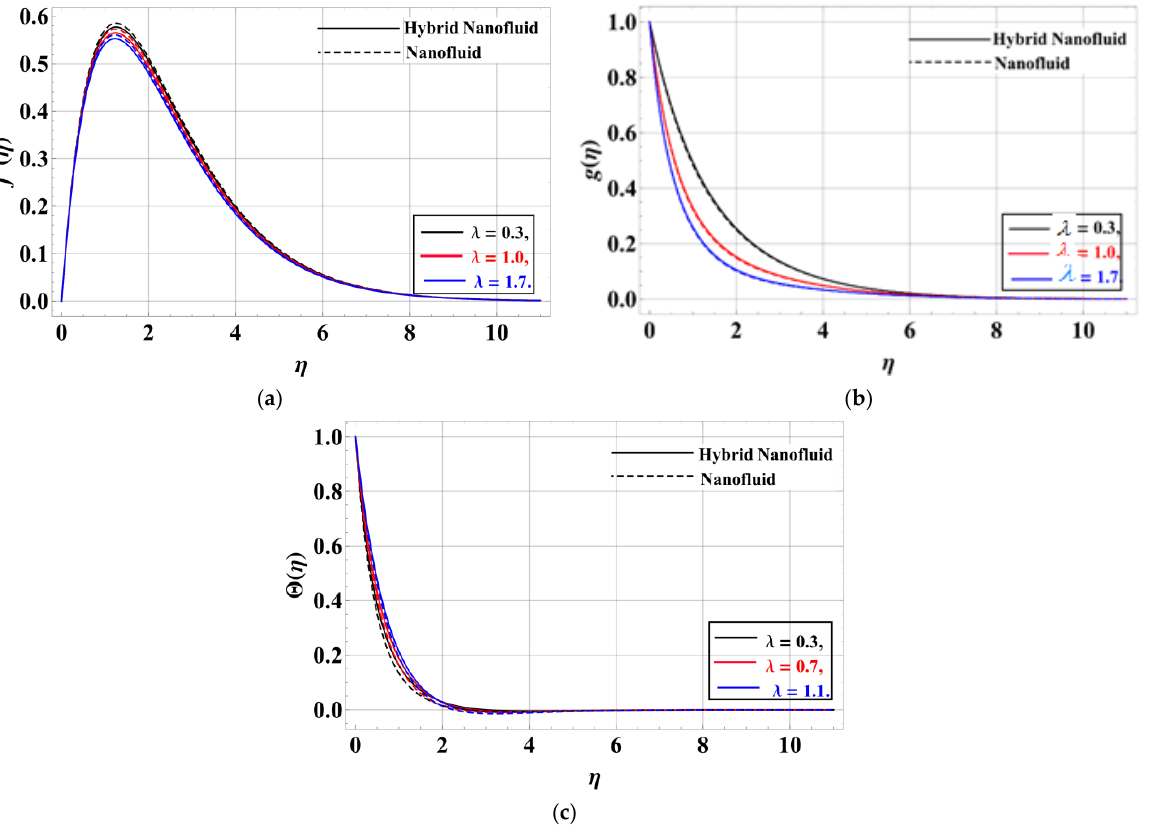
Figure 4. Variations in f (cid:48) ( η ) , g ( η ) & Θ ( η ) against λ . ( a ) Variations in f (cid:48) ( η ) against λ ( b ) Variations in g ( η ) against λ ( c ) Variations in Θ ( η ) against λ .